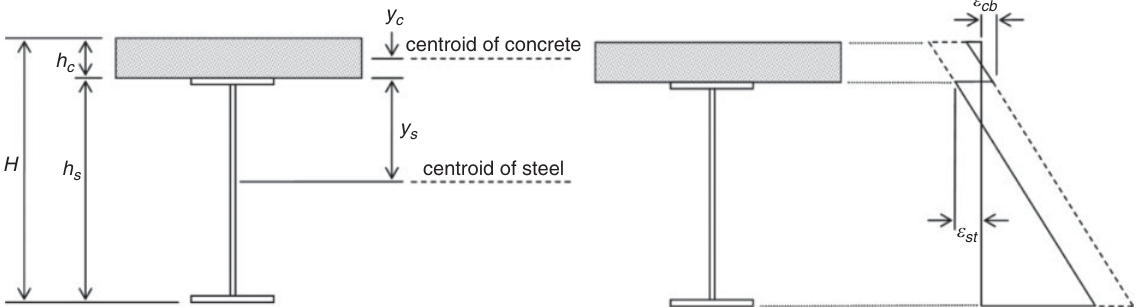
Fig. 2. Cross-section and strain distribution along the depth of a composite